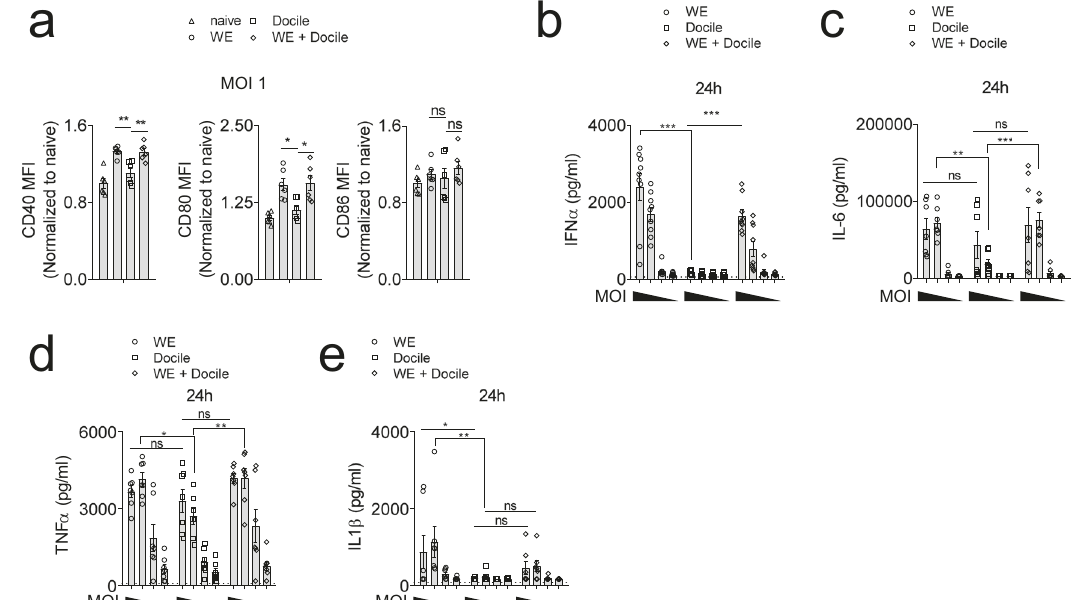
Fig. 3 LCMV-Docile failed to activate IFN-I production pathway. GM-CSF induced BMDCs were infected with LCMV-WE, LCMV-Docile, or co-infected at the indicated MOI 10, 1, 0.01 or 0.001. a co-stimulatory molecules expression was monitored by fl ow cytometry 24 h post-infection on CD11c + MHC-II + BMDCs (MOI = 1) ( n = 6, gating strategy is shown in Supplementary Fig. 5a). b IFN- α concentration was determined in the supernatant of LCMV infected BMDCs 24 h post-infection ( n = 9). c IL-6, d TNF- α , e IL-1 β levels were measured in the supernatant of LCMV infected BMDCs 24 h post-infection ( n = 7, dotted line indicated minimum detection limit). (Error bars show SEM, * p < 0.05, ** p < 0.01, *** p < 0.001, and ns indicates statistically not signi fi cant between the indicated (Supplementary Fig. 4e, f). Taken together, Docile infected mice demonstrated both impaired IFN-I production and decreased anti-LCMV T cell immunity.